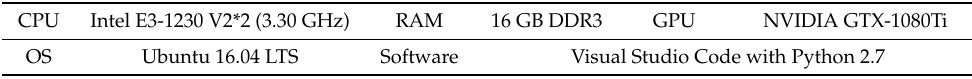
Table 5. Parameters of the experimental